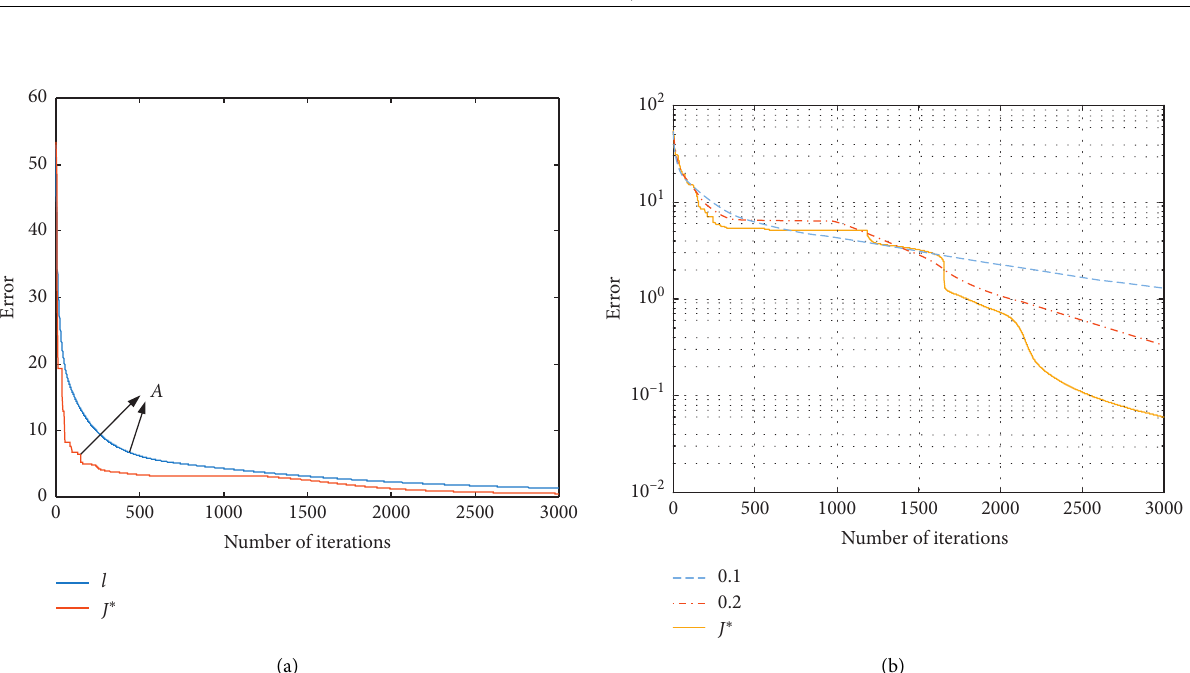
Figure 7: The relationship between the number of iterations and the training error under the different step-size update strategy. (a) J � J